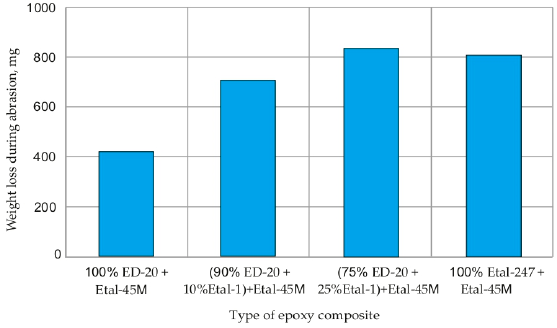
Figure 5. Loss of mass at abrasion of the EC (abrasive discs model H22, load on the disc 1000 g, 1000 cycles).